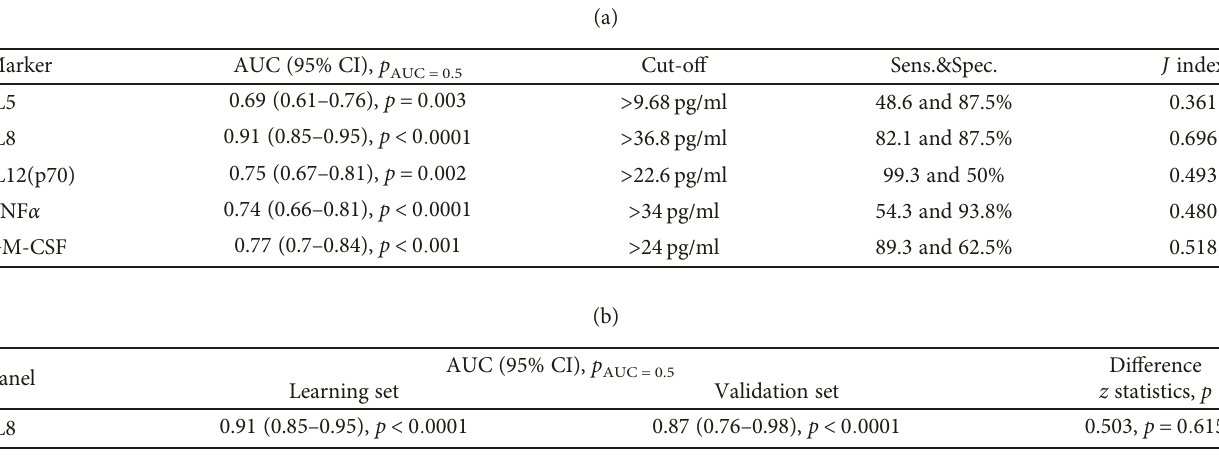
Table 4: Diagnostic power of eosinophil-associated cytokines as markers di ff erentiating active IBD from IBS.